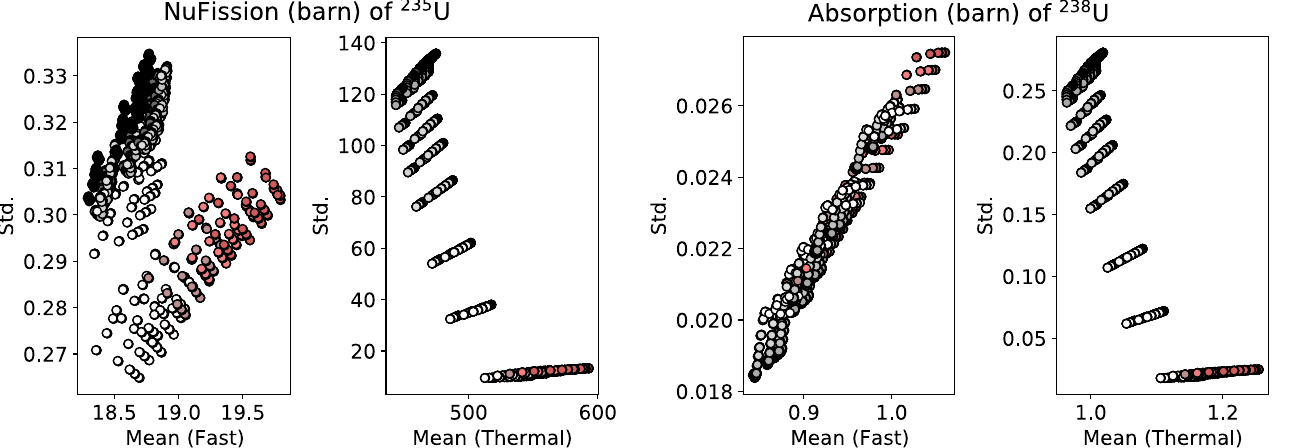
Fig. 2. Mean and standard deviation (Std) of the pin-wise absorption cross section of 238 U in the UGd fuel assembly.